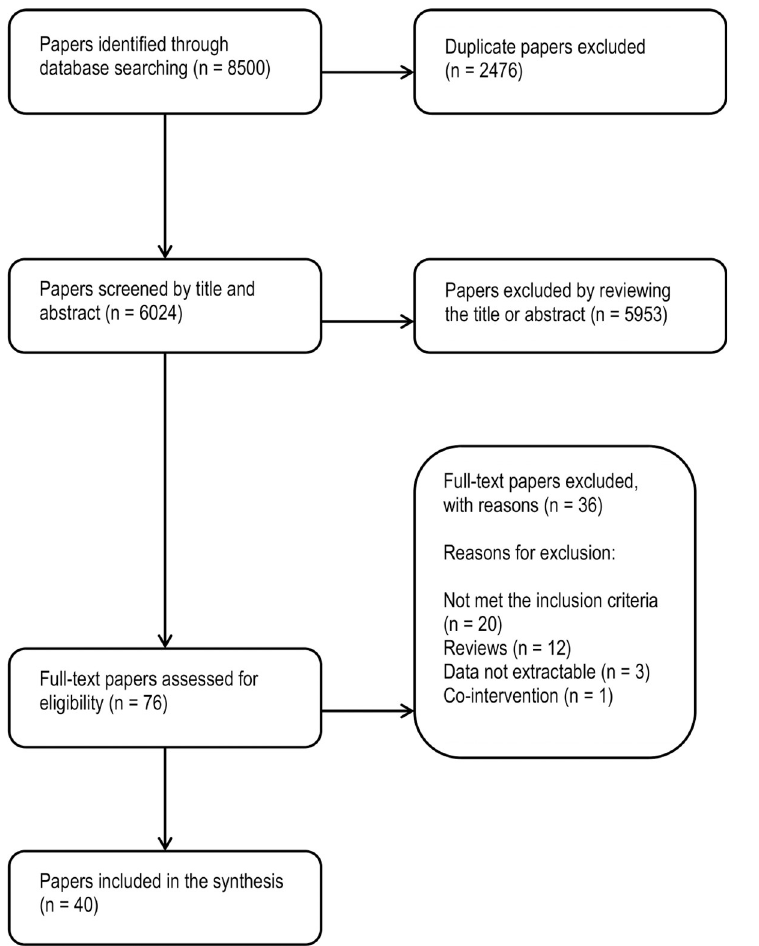
Fig 1. Process of selection of the studies for the systematic review (PRISMA flow